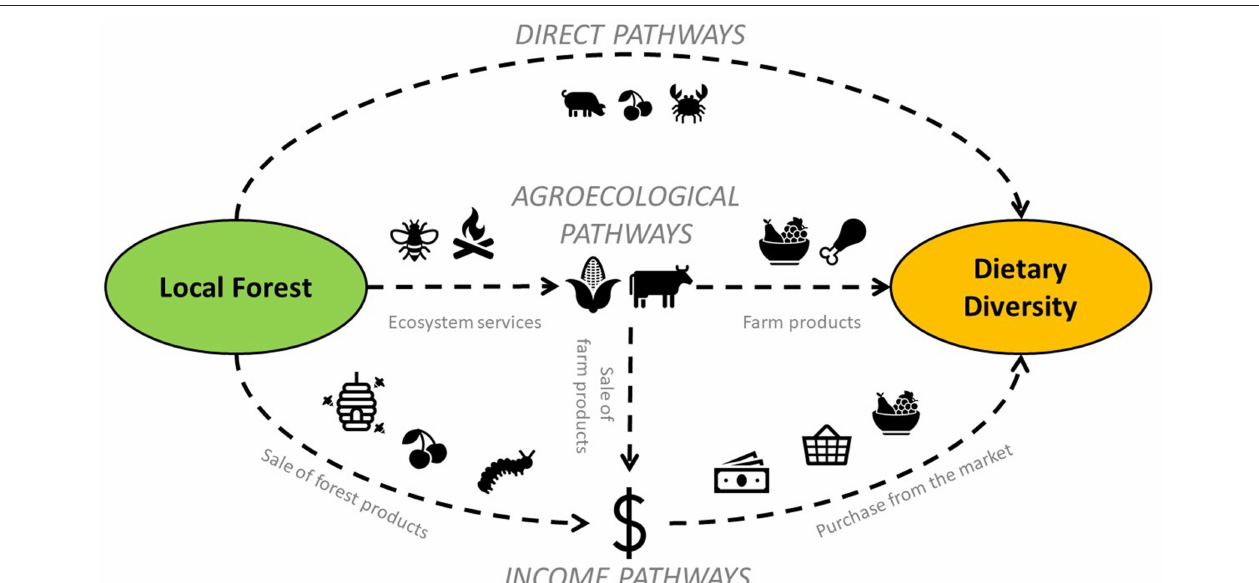
FIGURE 1 | Conceptual diagram representing the three main pathways linking forest cover to dietary diversity.